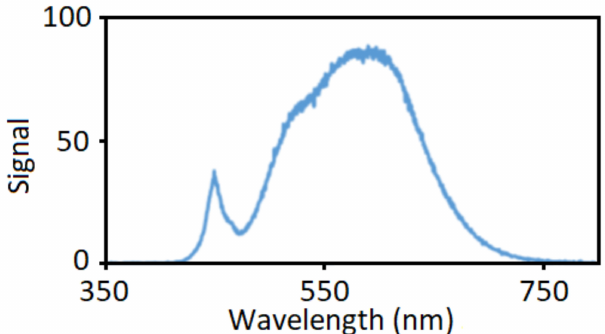
Figure 1. Normalized emission spectrum of an LED lamp employed as a light source for the photochemical reduction of AgNO 3 in hydroxypropyl methylcellulose (HPMC)